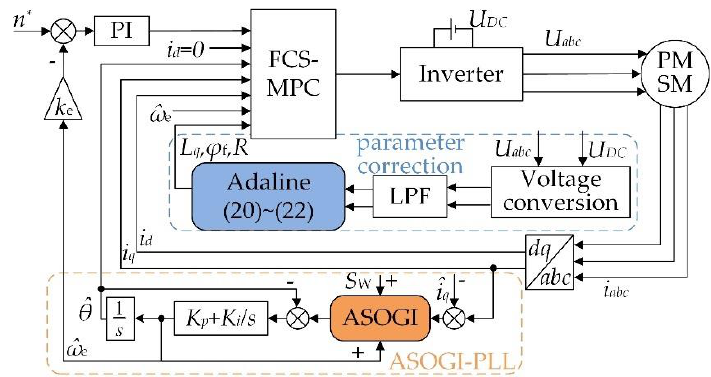
Figure 10. Overall block diagram.